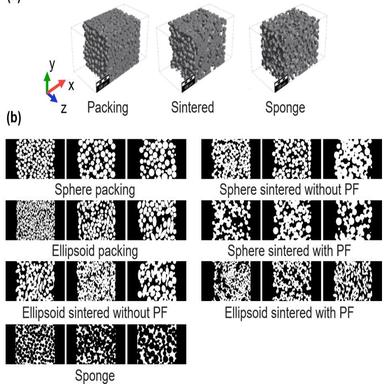
Porous material samples prepared using GeoDict®. (a) 3D images (flow is represented along the x direction, and all the samples have periodic boundaries in the y and z directions). (b) 2D cross-sectional images (the black and white pixels denote void and solid phase, respectively).